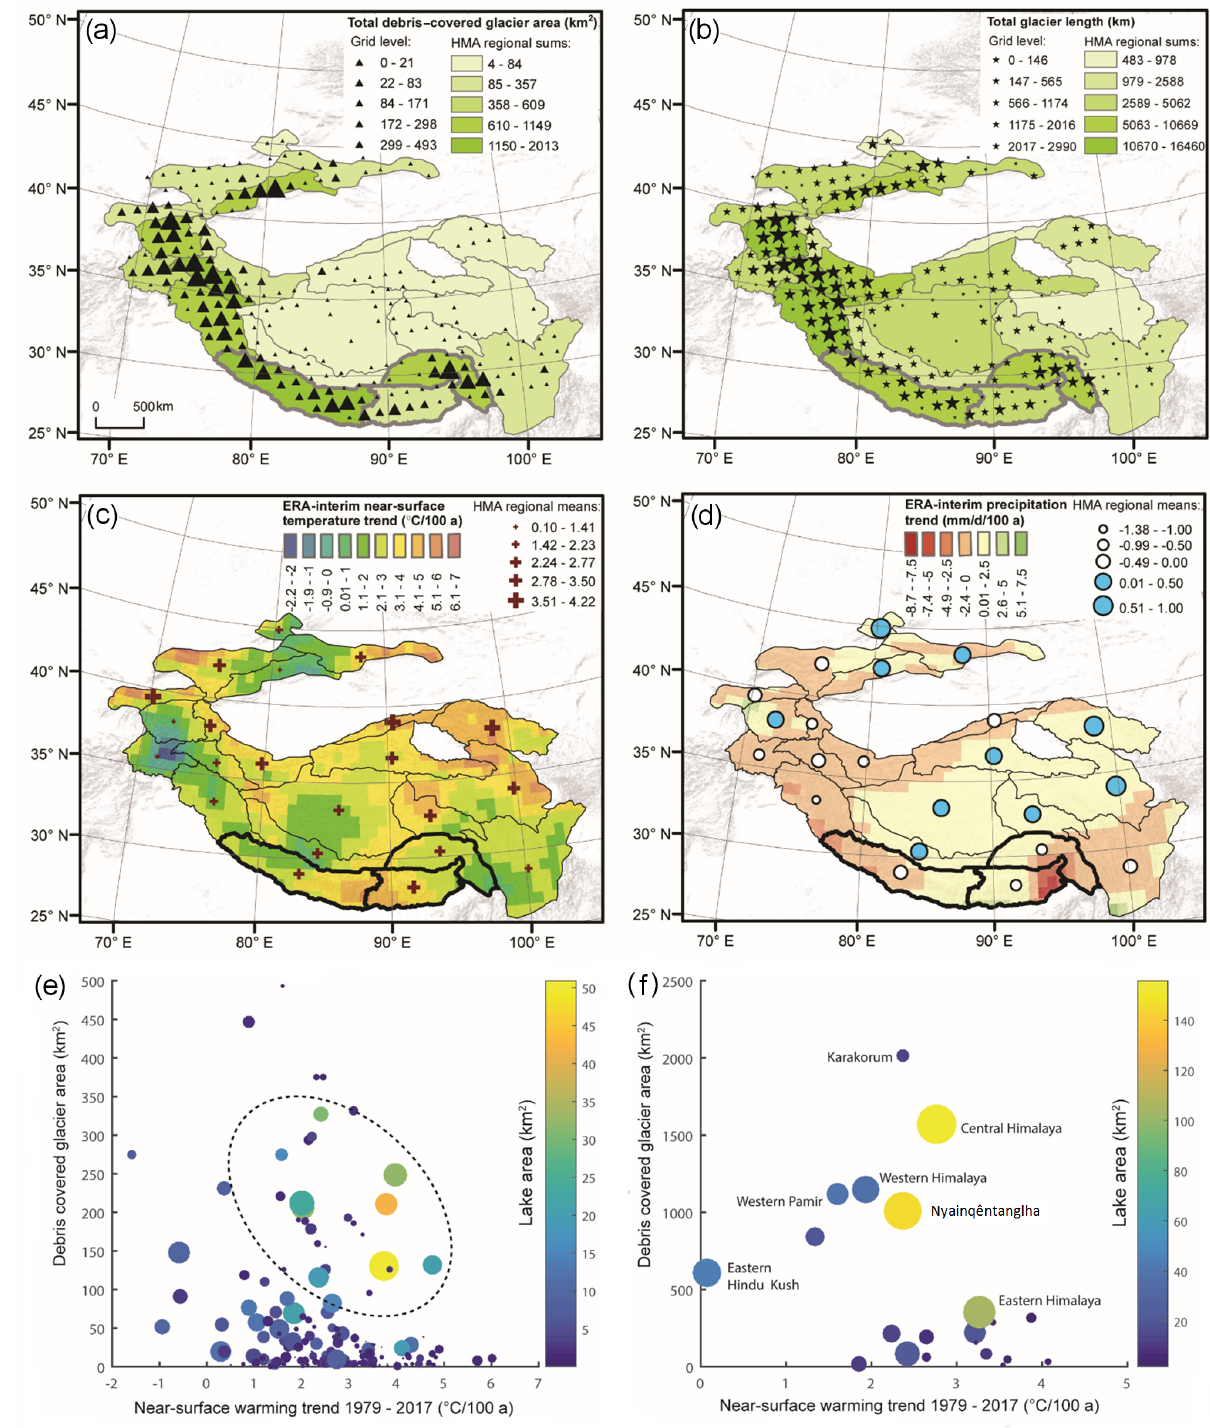
Figure 7. Geomorphic and climatic influences on lake distribution. (a) Debris-covered area and (b) glacier length aggregated on a 1 ◦ × 1 ◦ grid. Linear trends in (c) temperature and (d) precipitation calculated for 1979–2017 from ERA-Interim, including aggregated means over HMA regions. Relationship between total debris-covered area, near-surface temperature warming, and proglacial- and supraglacial-lake area of 2017 in (e) 1 ◦ × 1 ◦ grid tiles and (f) HMA regions. Some regions discussed in the text are labeled. The lake coverage is high in areas of both rapid warming and high debris cover ( e , dashed ellipse). Dot sizes are proportional to lake number. See Table A4 for details on data sources.